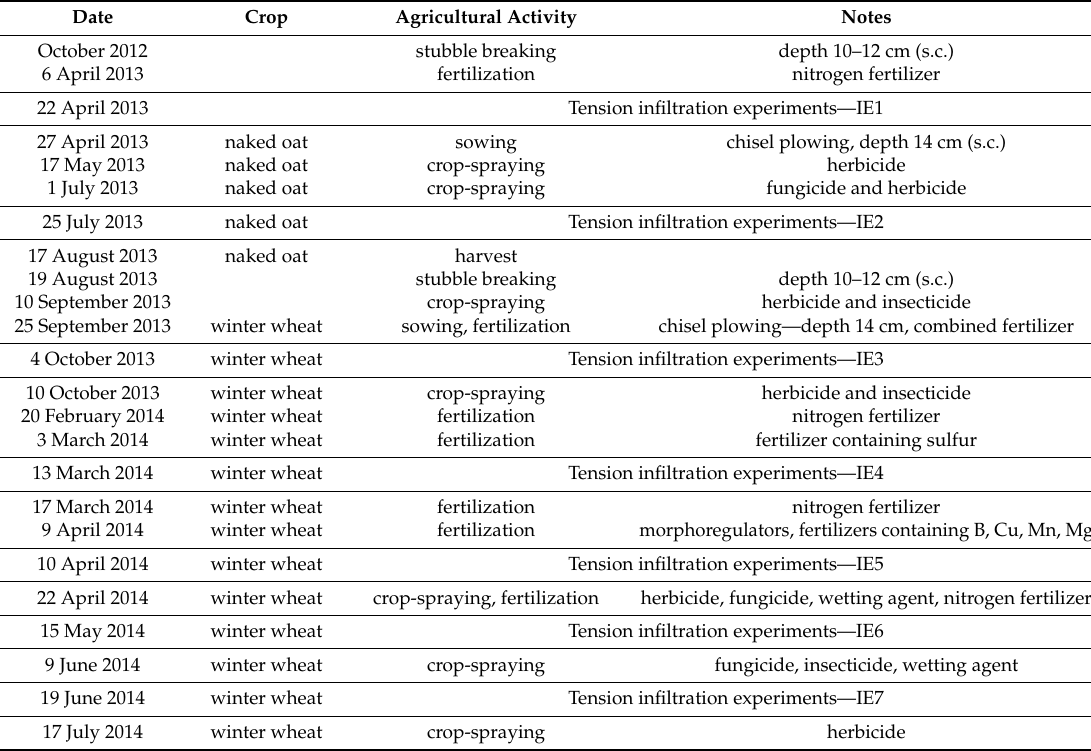
Figure 1. Geographic position and a map of the Nu č ice catchment. Table 1. General overview of the agricultural activities and infiltration experiments (lines highlighted in grey), seedbed cultivation (s.c.) is marked in the Notes column.